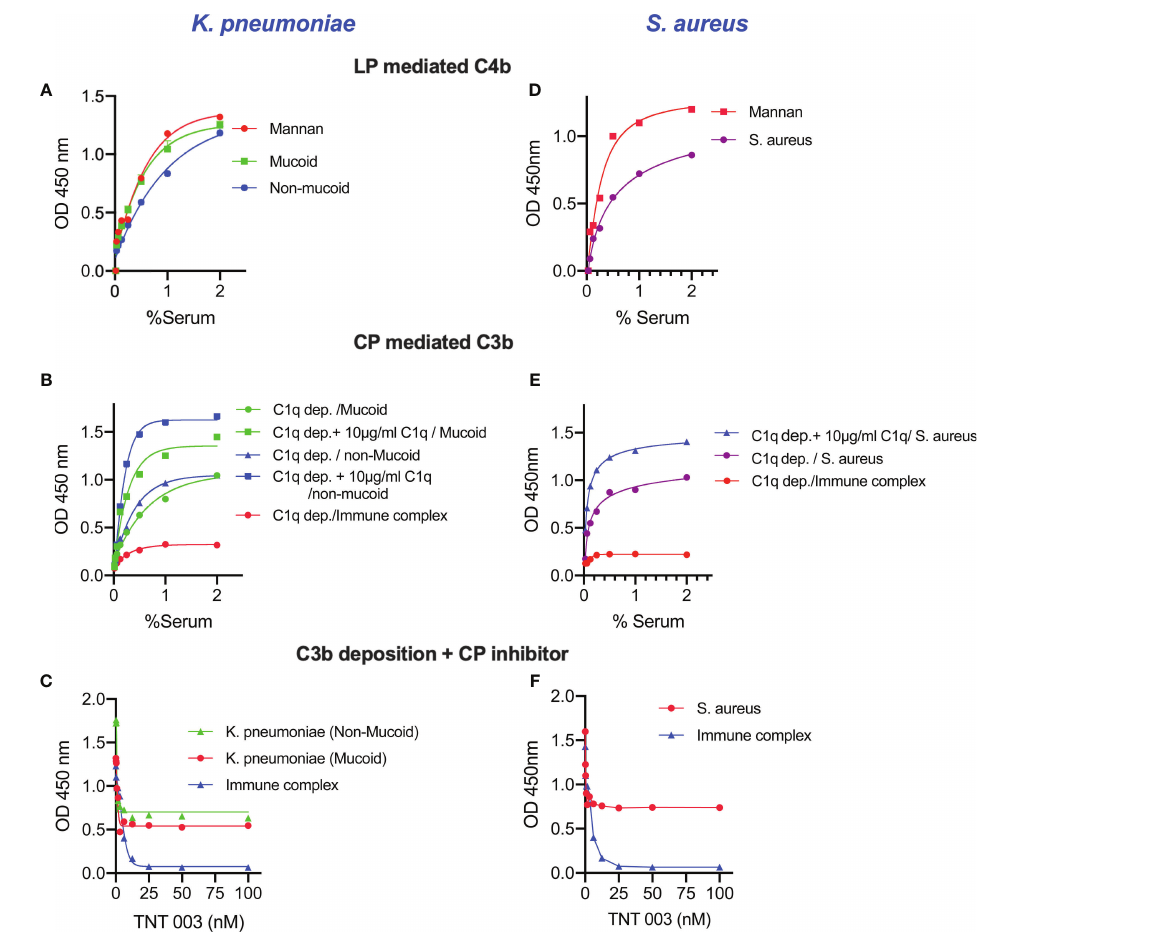
FIGURE 3 | Complement activation pathway-speci fi c assay conditions demonstrate that both LP and CP are activated on the surface of K. pneumoniae and S. aureus . ELISA plates coated with zymosan (as control), mucoid, non-mucoid strains of K. pneumoniae or S. aureus were incubated with NHS diluted in MBL-binding buffer for 1 h at 37°C then washed. Puri fi ed human C4 was incubated with the ELISA plate for another 1 h at 37°C. After washing steps, C4b deposition was detected. High levels of LP-mediated C4b deposition were observed in the surface of K. pneumoniae and S. aureus (A, D) . Likewise, the use of C1q- depleted serum resulted in a signi fi cant reduction of C3b deposition. In absence of CP functional activity, only LP-dependent C3b deposition was measured on the surface of K.pneumoniae and S. aureus . Reconstitution of C1q-depleted serum with puri fi ed human C1q restored CP-mediated C3b deposition. No C3b deposition was observed when using C1q-depleted serum on the surface of immune complexes (B, E) . Using the C1s inhibitory antibody TNT003 blocked CP-mediated C3b deposition on the surface of immune complexes and all CP-mediated C3b opsonisation on K. pneumoniae and S. aureus . Under the chosen assay conditions, the residual deposition of C3b on Klebsiella and S. aureus is LP-mediated (C, F) . Results are means of duplicates ±